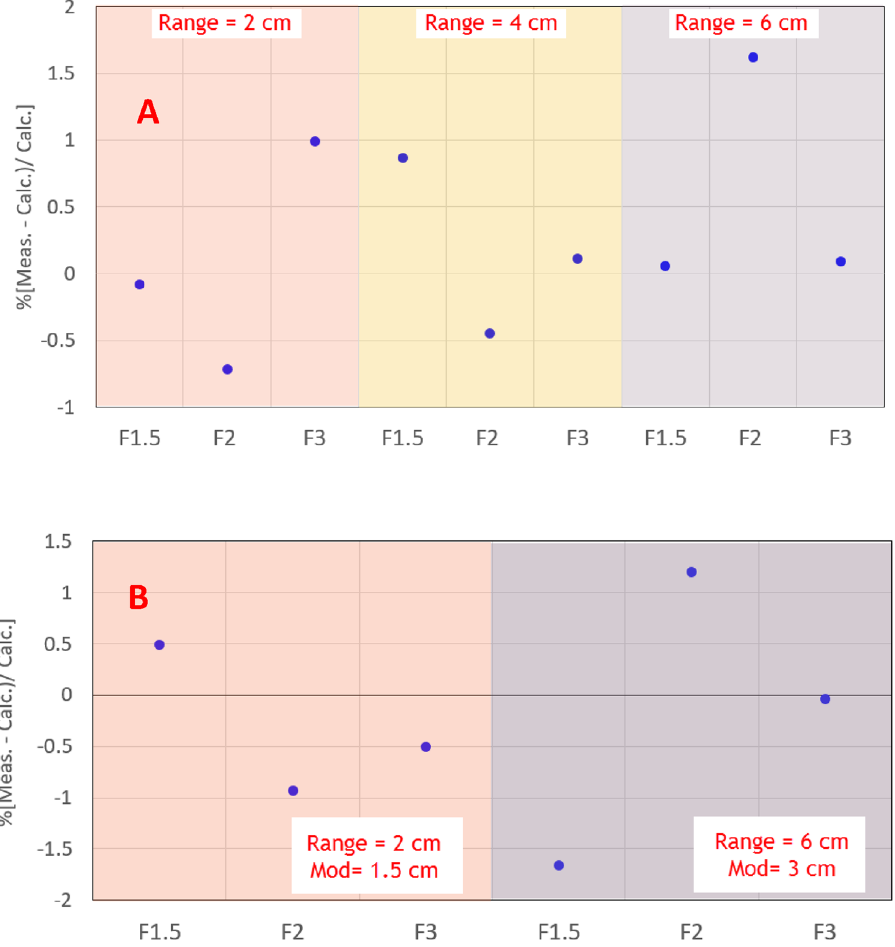
Figure 5. ( A ) Absolute point dose difference between measured and calculated depth dose around entrance region of three Bragg peaks as a function of circular field size. ( B ) Absolute point dose difference between measured and calculated depth dose around the center for SOBPs beams as a function of circular field